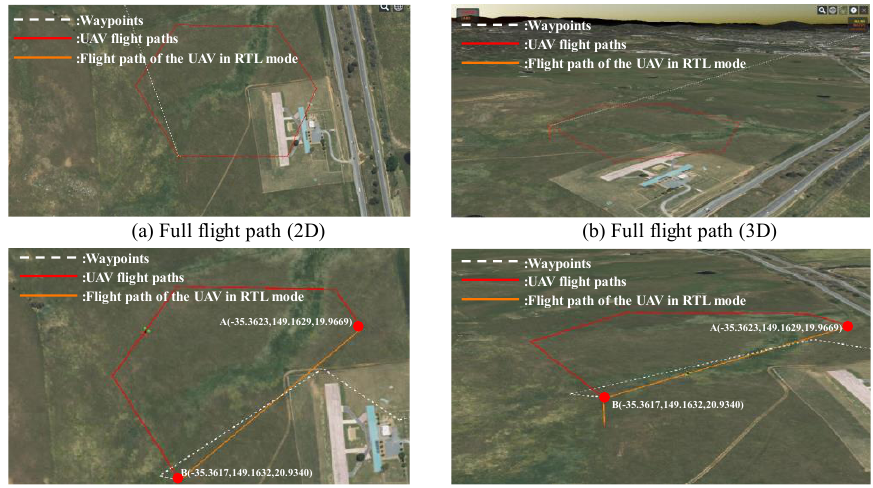
Figure 15. The flight trajectory of the UAV in the normal state and the fault state.